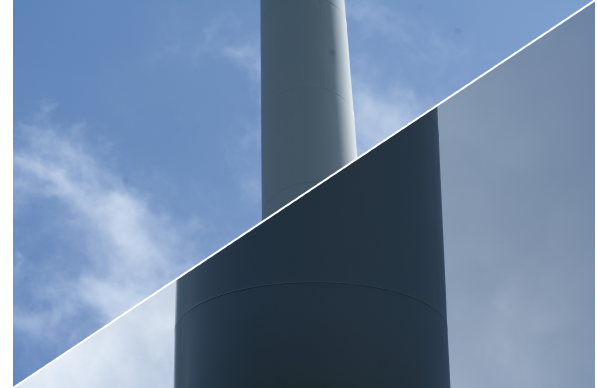
Figure 2. Visualization of the orientation of the texture.